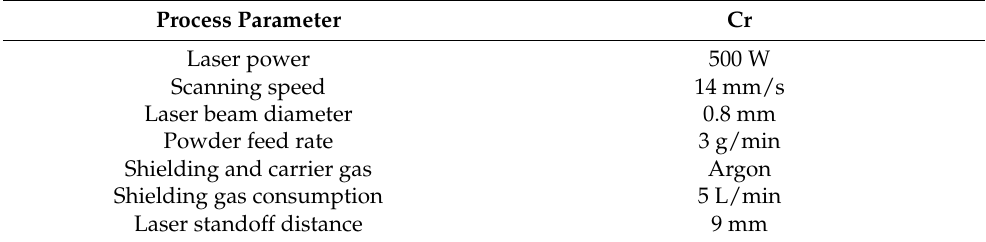
Table 1. Process parameter for DED. Process Parameter